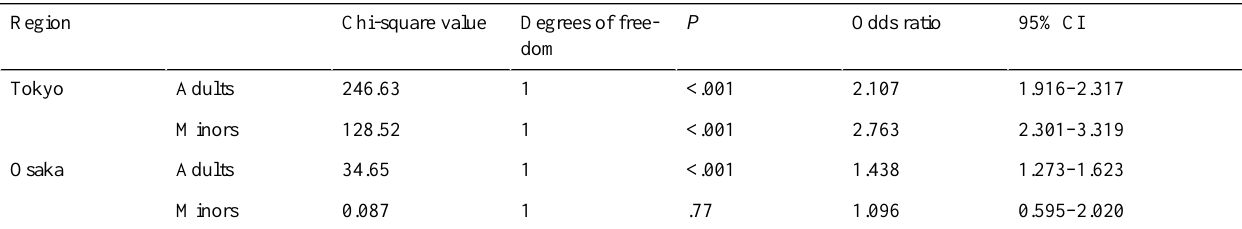
Table 2. Chi-square analysis according to sex and